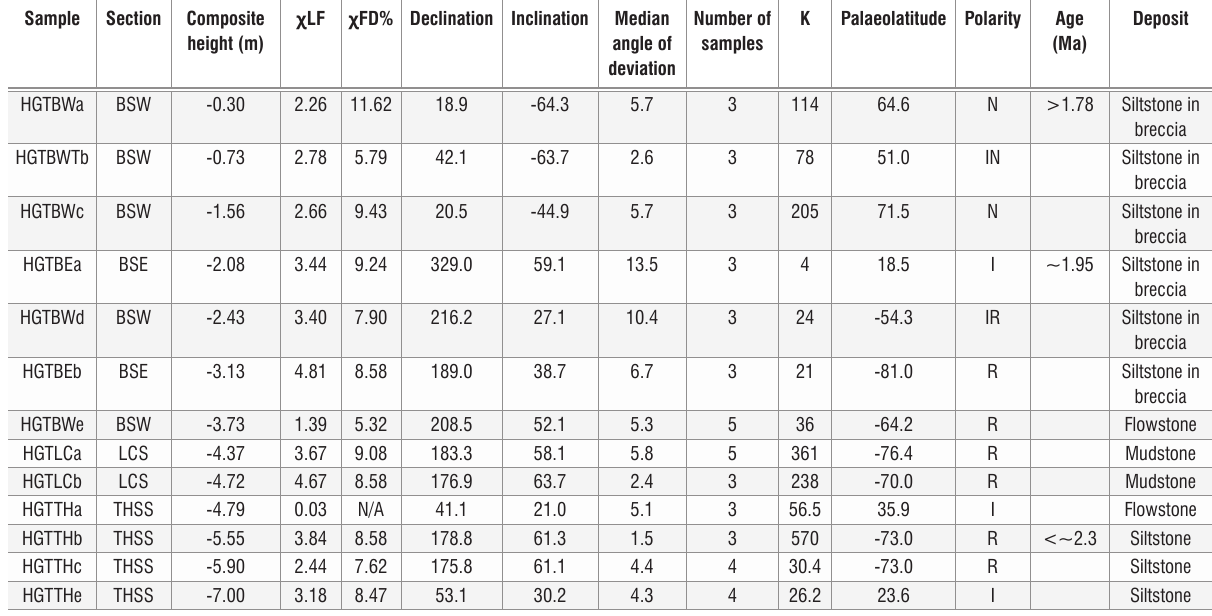
Table 1: Palaeomagnetic and mineral magnetic results from the Haasgat (HGT) fossil site